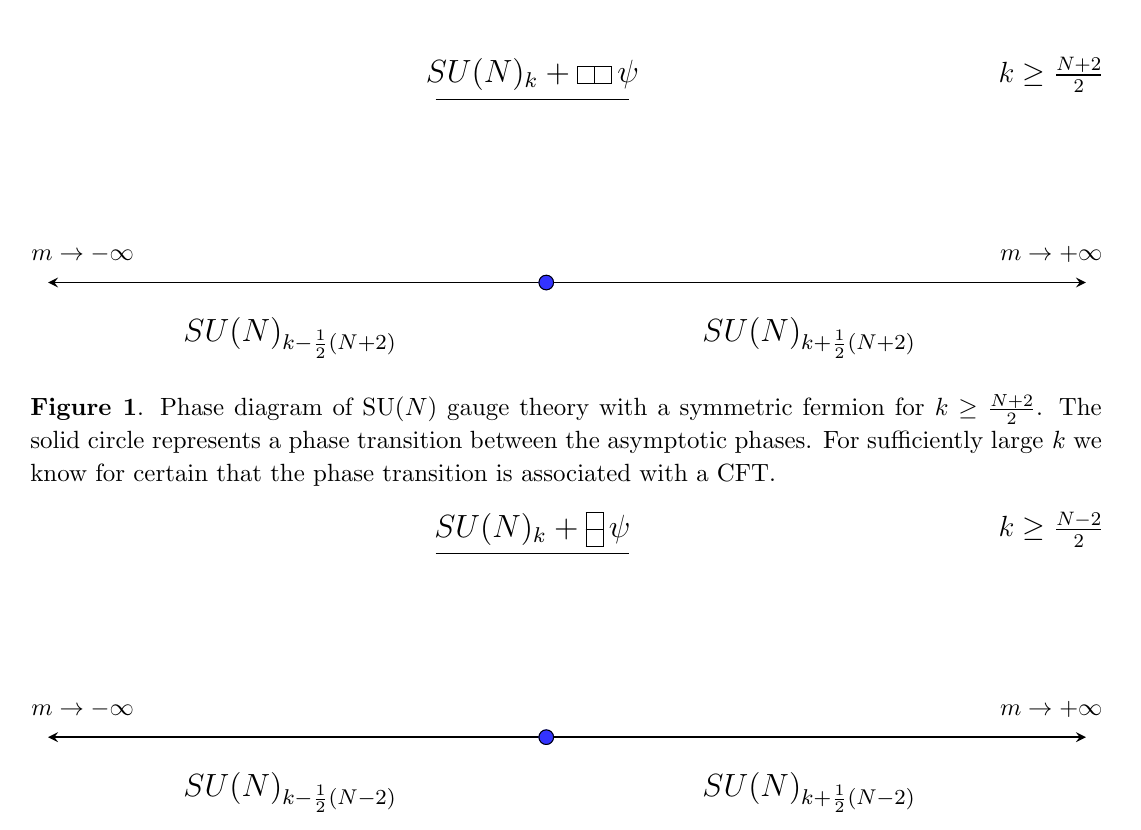
Figure 2 . Phase diagram of SU( N ) with an antisymmetric fermion for k (cid:21) N (cid:0) 2 represents a phase transition between the asymptotic phases. For su(cid:14)ciently large k we know for certain that the phase transition is associated with a